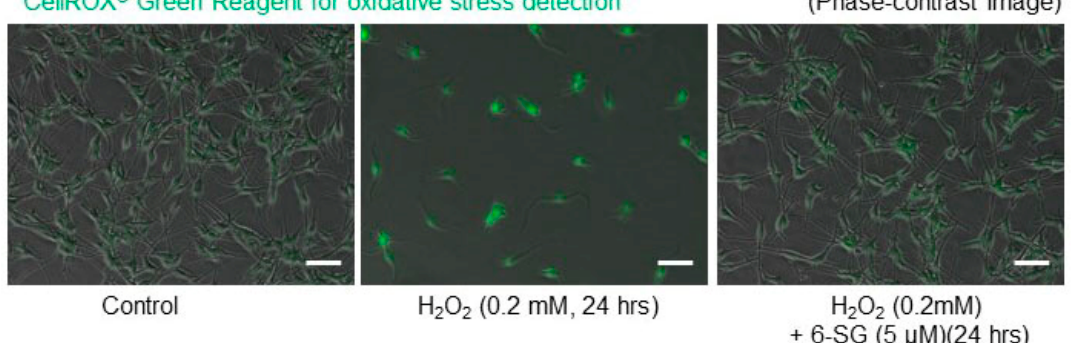
Figure 3. Oxidative stress in cultured human epidermal melanocytes. Oxidative stress in cultured cells was detected by CellROX ® Green reagent after exposure to the indicated treatments with 6-SG for 24 h. Cultured cells were photographed by phase-contrast and confocal fluorescence microscopy. Typical images obtained in three independent experiments are shown. White bar = 50 µm.